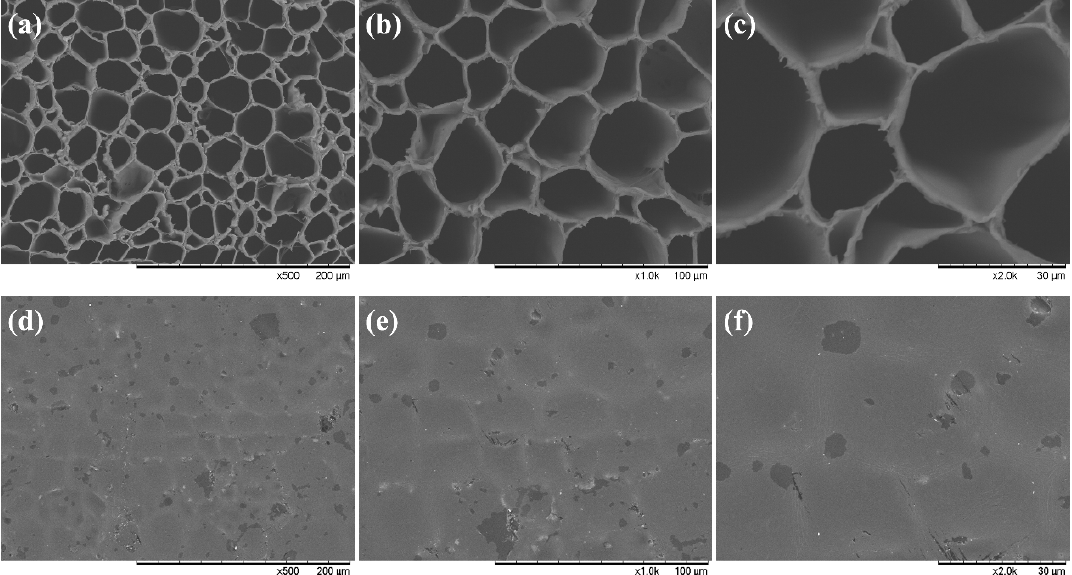
Figure 4. The SEM images of ORW ( a – c ) and FUW ( d – f